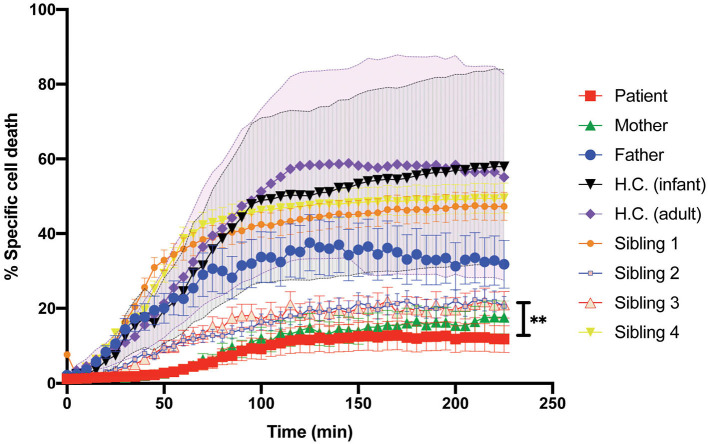
Killing activity of the patient CD8+ cells evaluated with the early-Tox caspase-3/7 assay. Target and effectors cells were incubated separately with a membrane-permeable NucView-488 caspase 3/7 substrate during 30 min. CD8+ cells from patient (red), mother (green), father (blue), and age-matched H.C. (infants: black; adults: purple) were activated with OKT3 15-min previous incubation with the substrate ends. Effectors and target cells were combined in 10–1 ratio in a black flat-bottom 96-well-plate. The green fluorescence signal was measured in each cell for 225 min with an interval of 5 min in a fluorescence cell imager ImageXpress Pico. The percentage of specific cell death was quantified as the percentage of cells that became positive for green fluorescence over time. H.C. range was established for both adults (pink shade) and infants (gray shade) from at least three to five different samples. Plots are mean ± SD of at least three independent experiments. Statistical analysis was done by one-way ANOVA **p < 0.01.